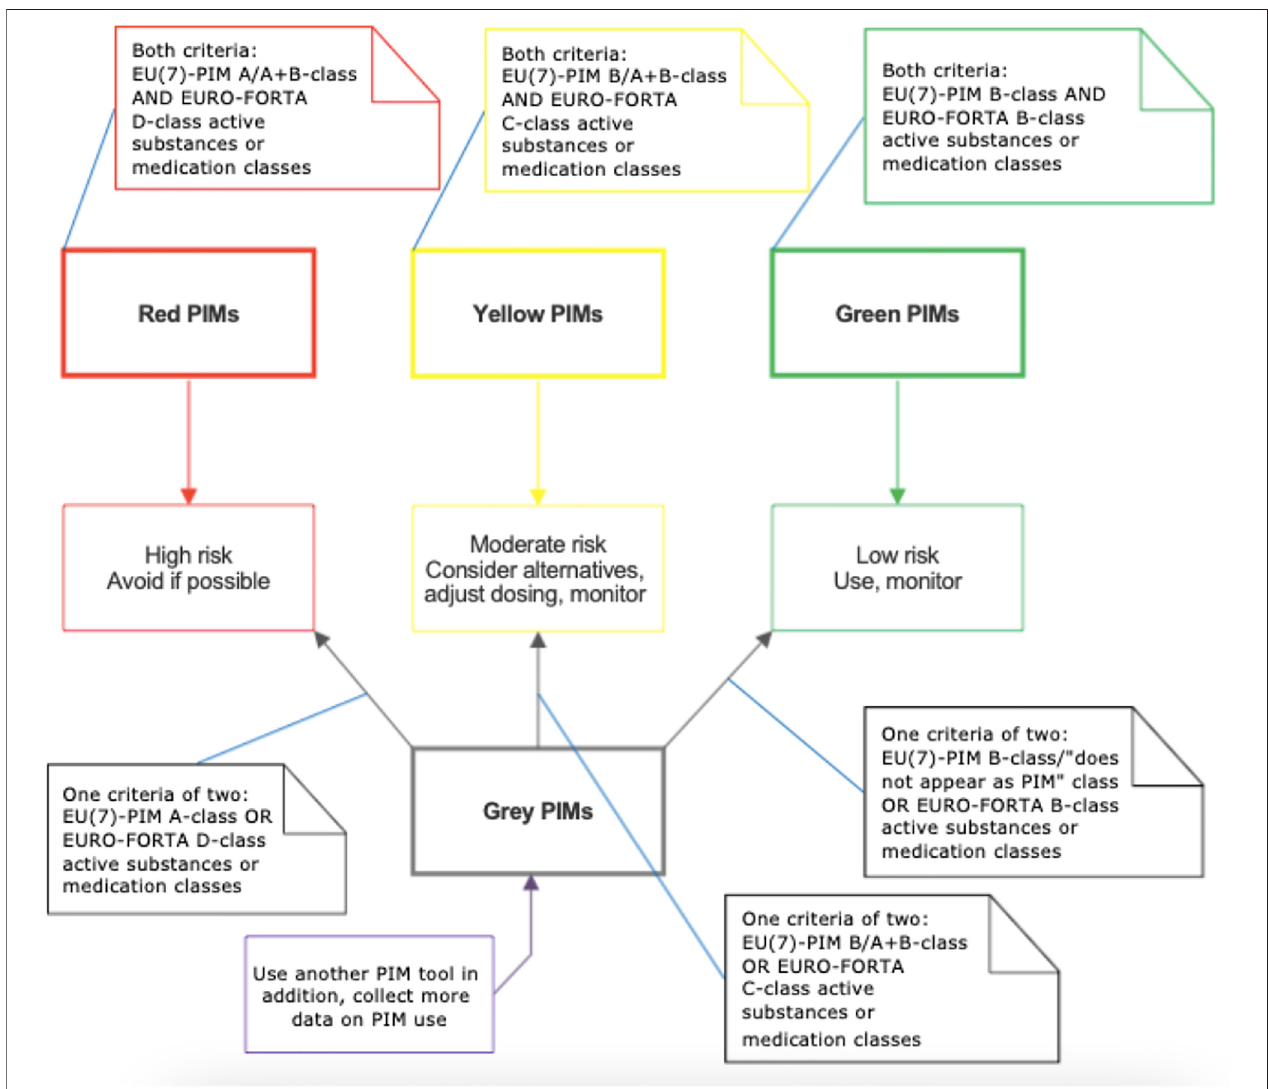
FIGURE 1 | The classi fi cation of potential inappropriate medications (PIMs) according to the integrated screening PIM tool based on the EU(7)-PIM 1 and EURO- FORTA 2 lists.